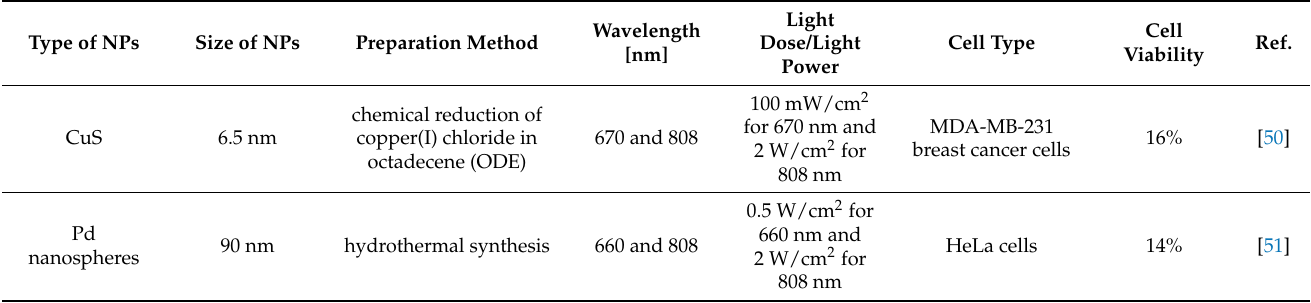
Table 4. A summary of the data presented in Section